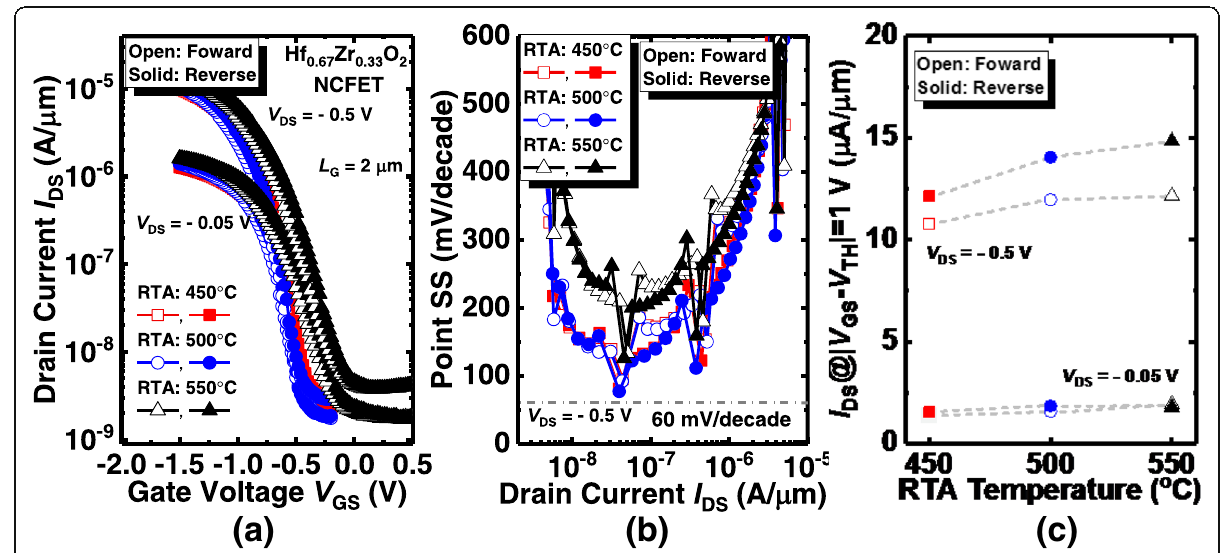
Fig. 6 ( a ) Measured I DS - V GS of the Hf 0.67 Zr 0.33 O 2 NC Ge pFETs annealed at 450 °C, 500 °C, and 550 °C. ( b ) Point SS vs. I DS characteristics of the devices. ( c ) I DS for the ferroelectric NC transistors with different annealing temperatures at a gate overdrive of 1 V